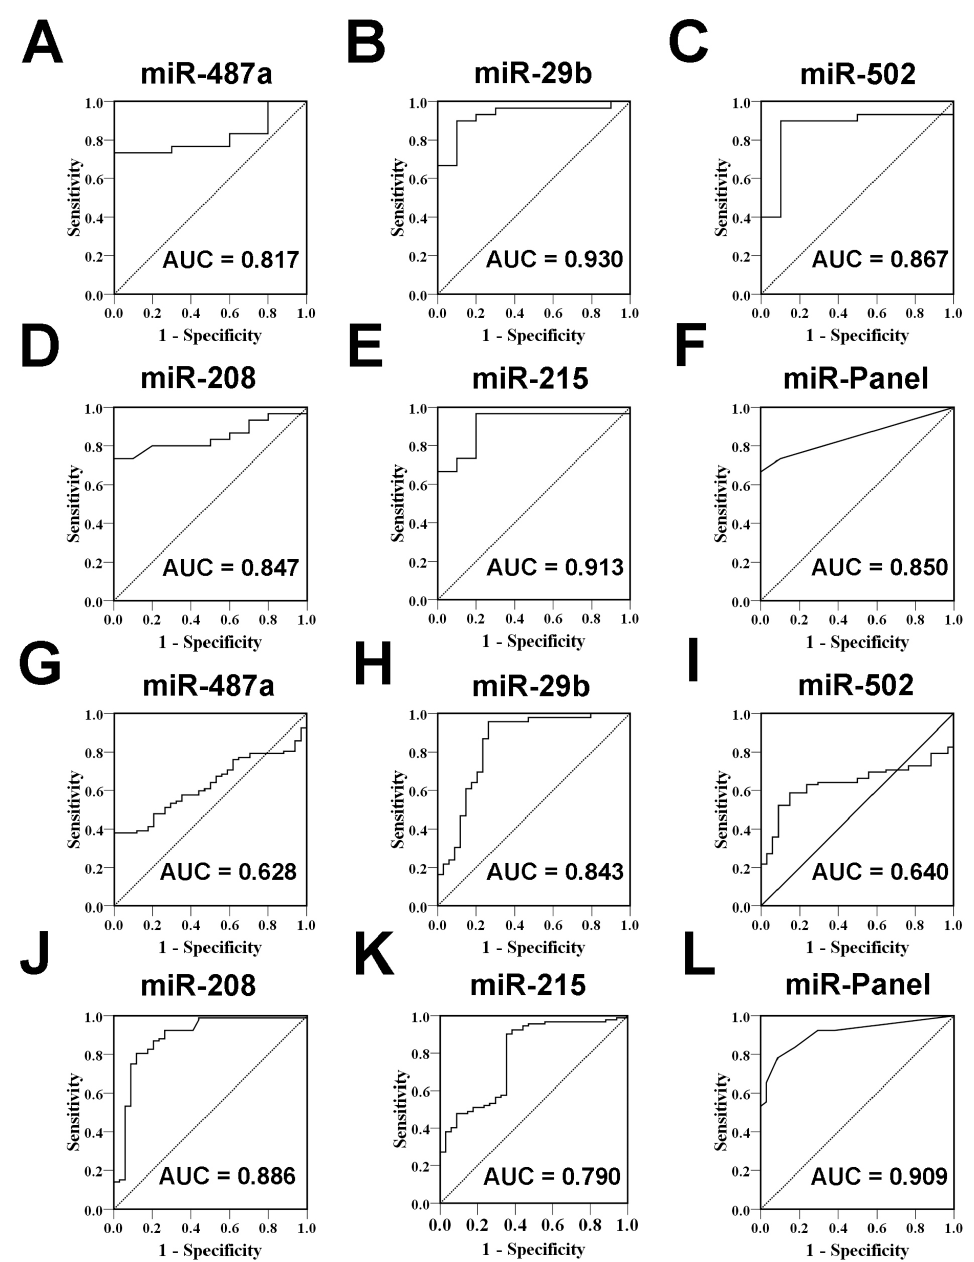
Figure 3. The receiver operating characteristic (ROC) curve analysis for discriminative ability between the Atypical Coronary Artery Disease (ACAD) cases and noncancer controls by the 5 miRNAs and their panel. ROC curves for the ability of the the 5 miRNAs and their panel to differentiate the 30 ACAD cases from the 10 controls in the training set (A–F), 92 ACAD cases from the 30 controls in the validation set (G–L).